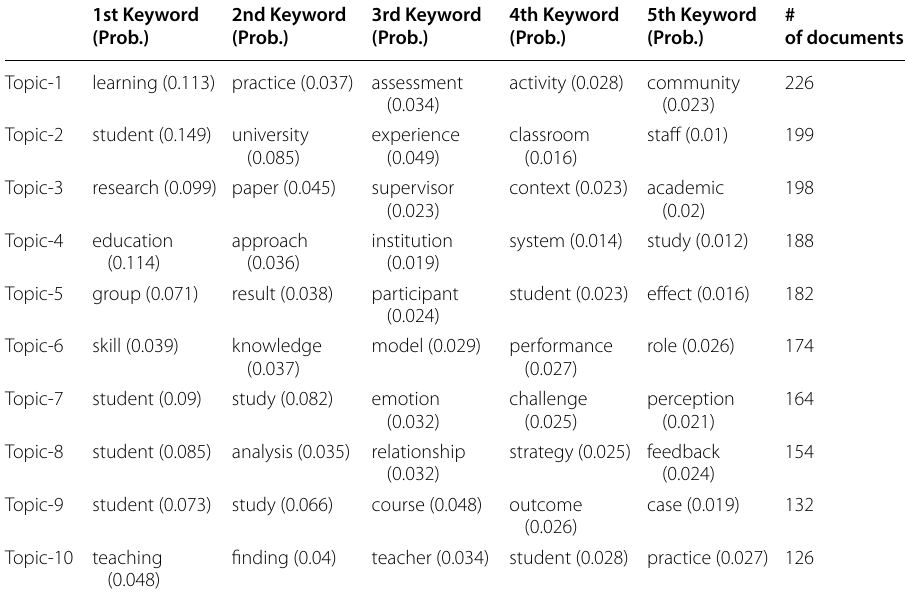
Table 4 Topic modeling using LDA (Latent Dirichlet allocation